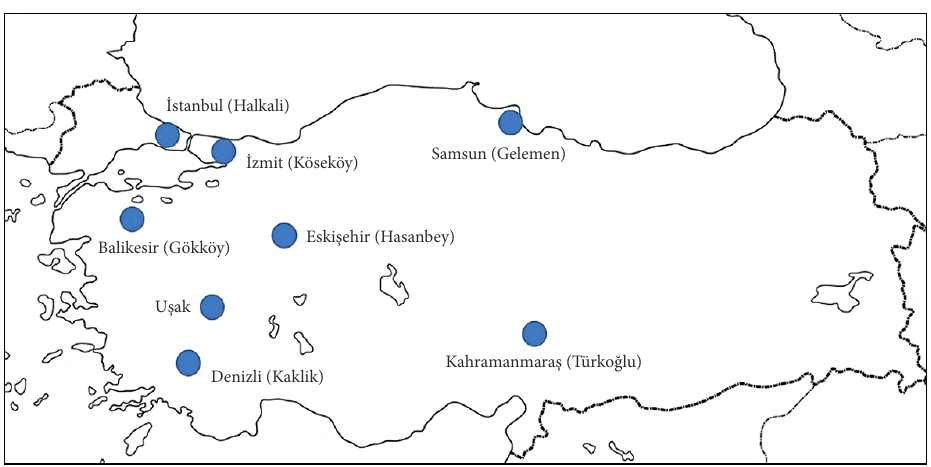
Figure 2. The decision alternatives for logistics village (centers) in